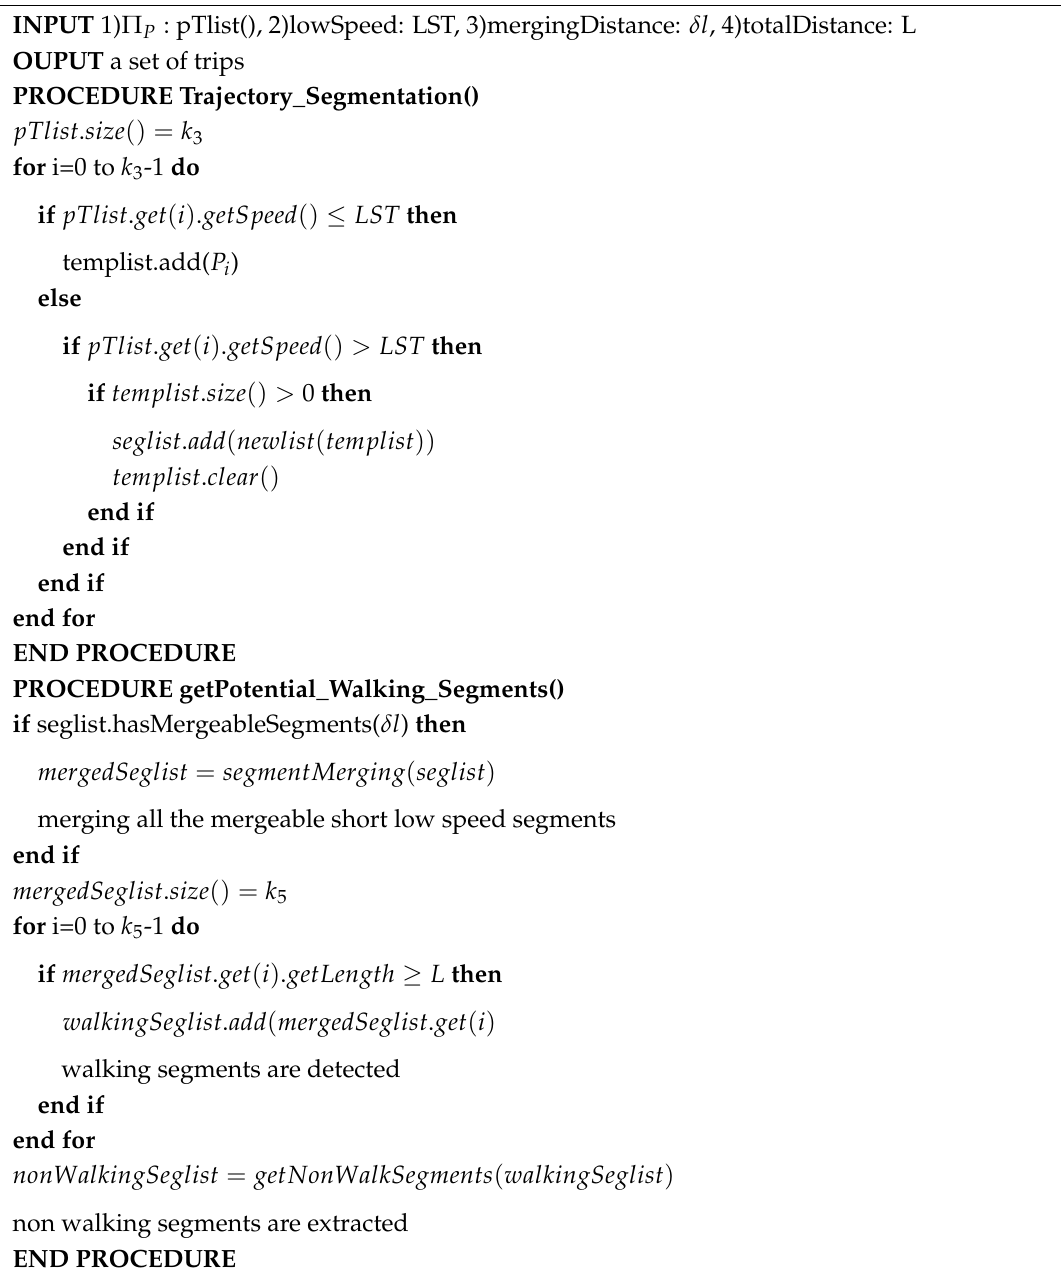
Algorithm 2 Trip generation using walking-based